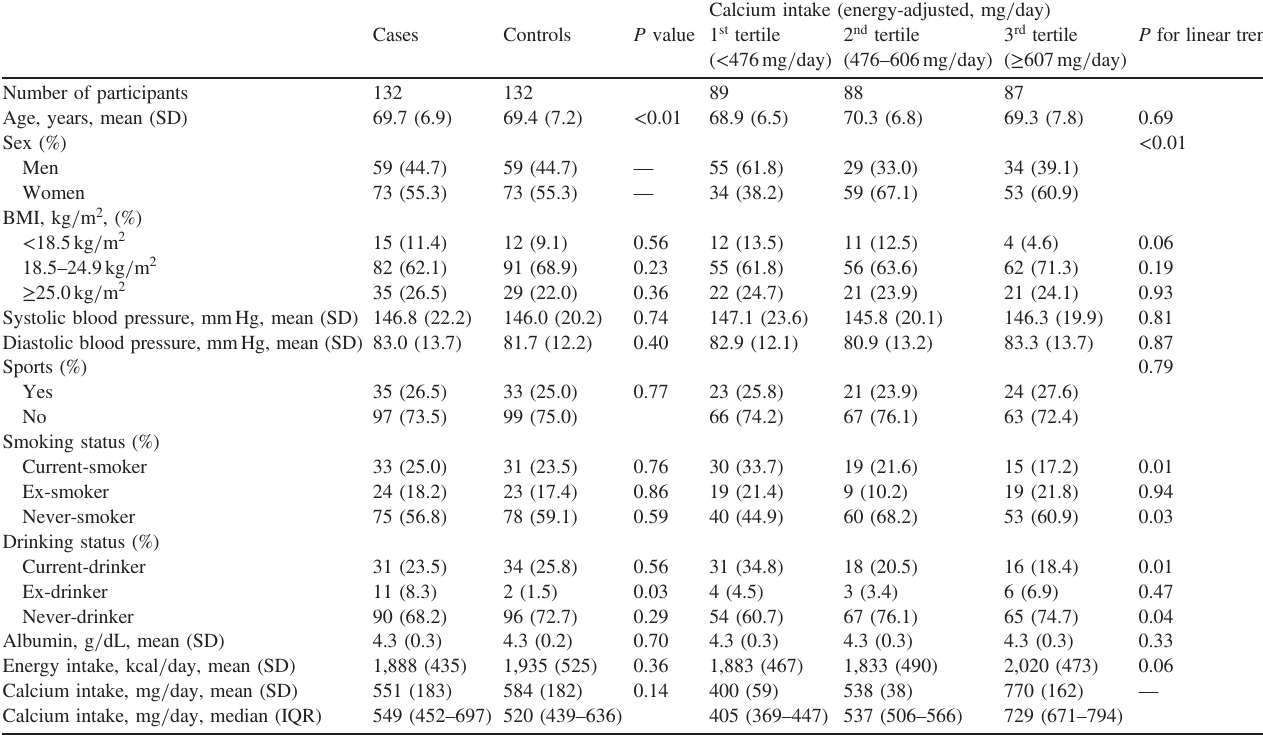
Table 1. Baseline characteristics of study participants in 2000, NIPPON DATA90 ( n = 264; 132 pairs)